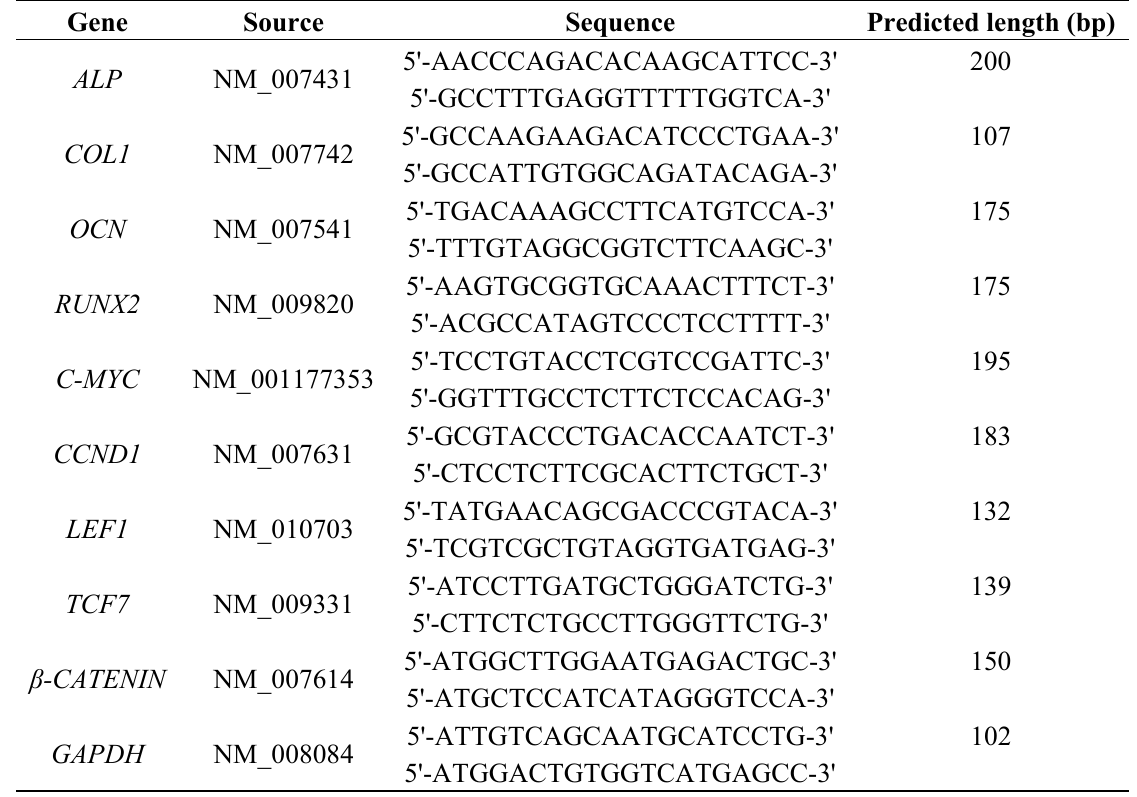
Table 1. Sequences of the primers used in this